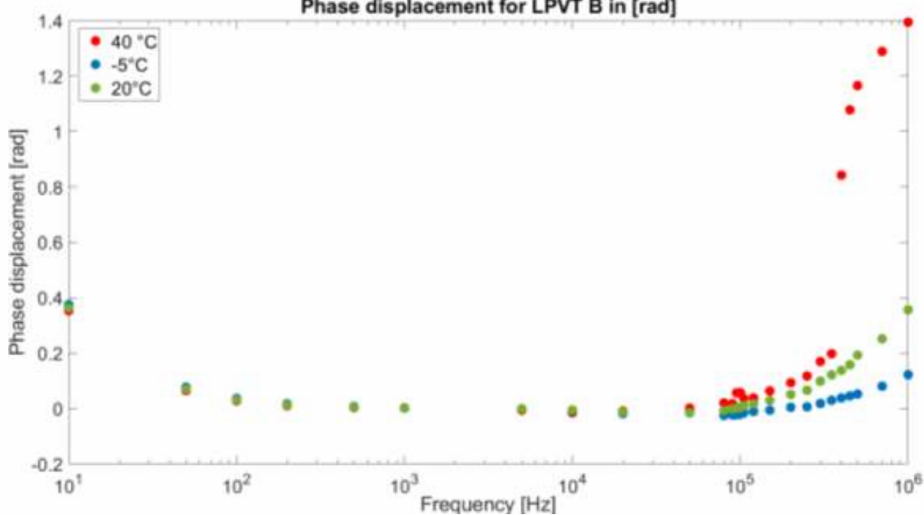
Figure 8. Phase displacement between ( V s ) and different